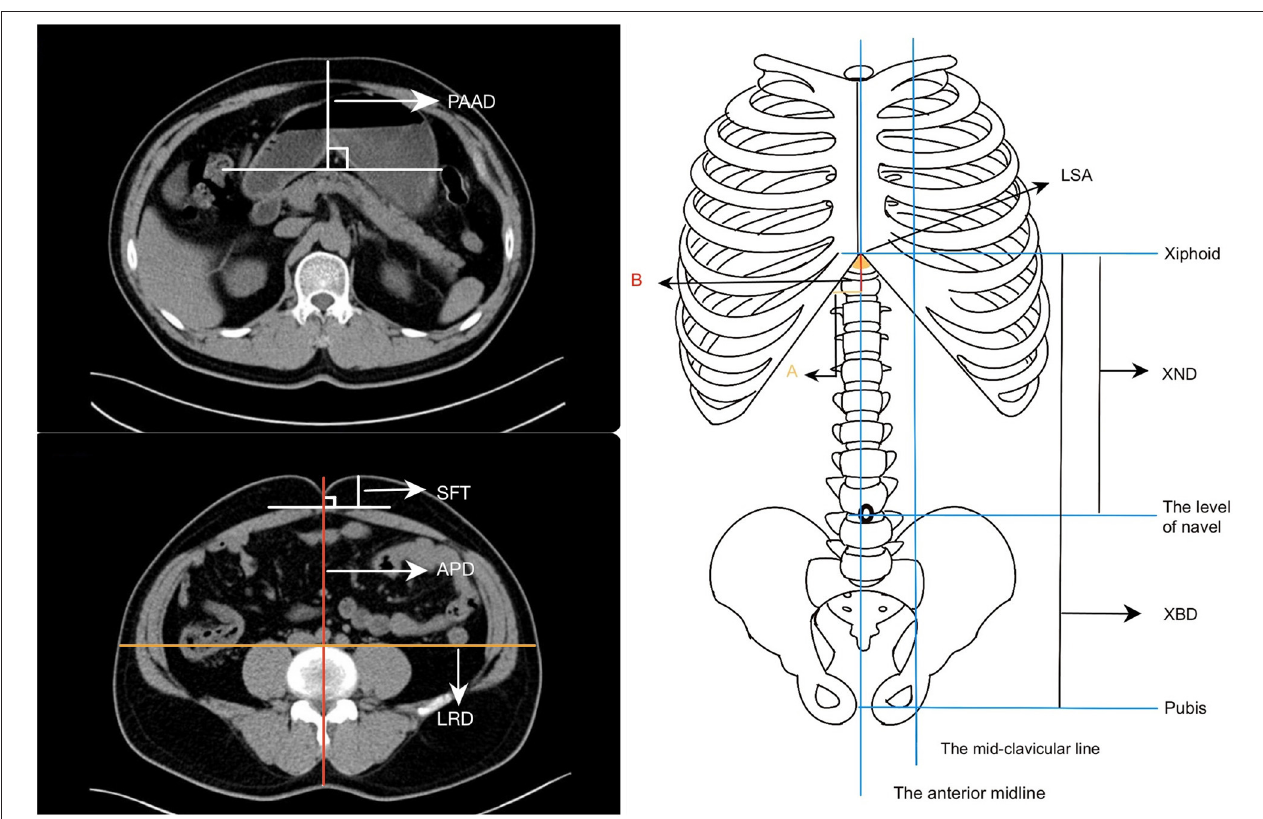
FIGURE 1 | Parameters of the abdominal shape. (a) The shortest distance of the pancreas from the anterior abdominal skin (PAAD). (b) The thickness of the subcutaneous fat at the navel level (SFT), the anteroposterior diameters (APD) and the left-right diameters (LRD) at the navel level. (c) The lower sternum angle (LSA), the distance from the xiphoid process to the navel (XND), and the distance from the xiphoid process to the pubis